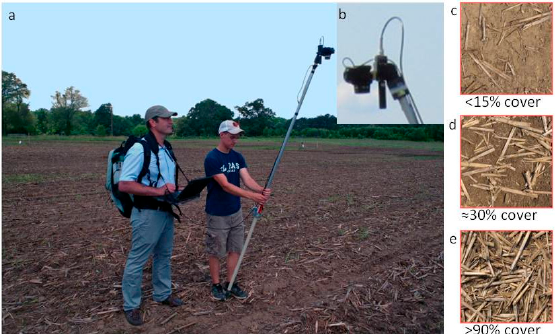
Figure 1. Photographs of: ( a ) the image and spectra acquisition from the research field in Beltsville, MD, USA; ( b ) detail of the digital camera and the 18° fore optic of the spectroradiometer aligned; and examples of the soil surface covered by ( c ) <15%; ( d ) 30% and ( e ) >90% of crop residues. On 25 July 2014, after reflectance spectra were acquired for each plot, one block (5 plots) was uniformly sprinkled with about 5 mm of water to increase the range of moisture content of the maize residues and soil surface. After 1 h, reflectance spectra were acquired from all plots. On the afternoon of 29 July, one block (5 plots) were sprinkled with about 8 mm of water and covered with a polyethylene sheet. The next morning, the plots were uncovered, and reflectance spectra were acquired multiple times as the soils and residues dried. Reflectance spectra were also acquired of a bare soil plot that was progressively covered with saturated crop residues until full coverage was achieved. Overall, 410 field reflectance spectra and digital images were acquired covering a broad range of f R and scene moisture contents.